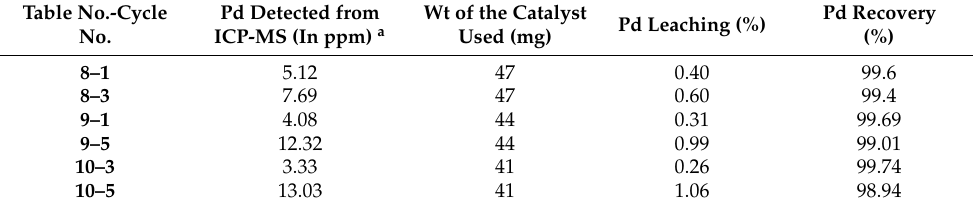
Table 14. Pd leaching (%) after 2a–c -catalyzed Suzuki-Miyaura coupling of aryl bromides from ICP-MS. Table No.-Cycle Pd Detected from Wt of the Catalyst No. ICP-MS (In ppm) a Used